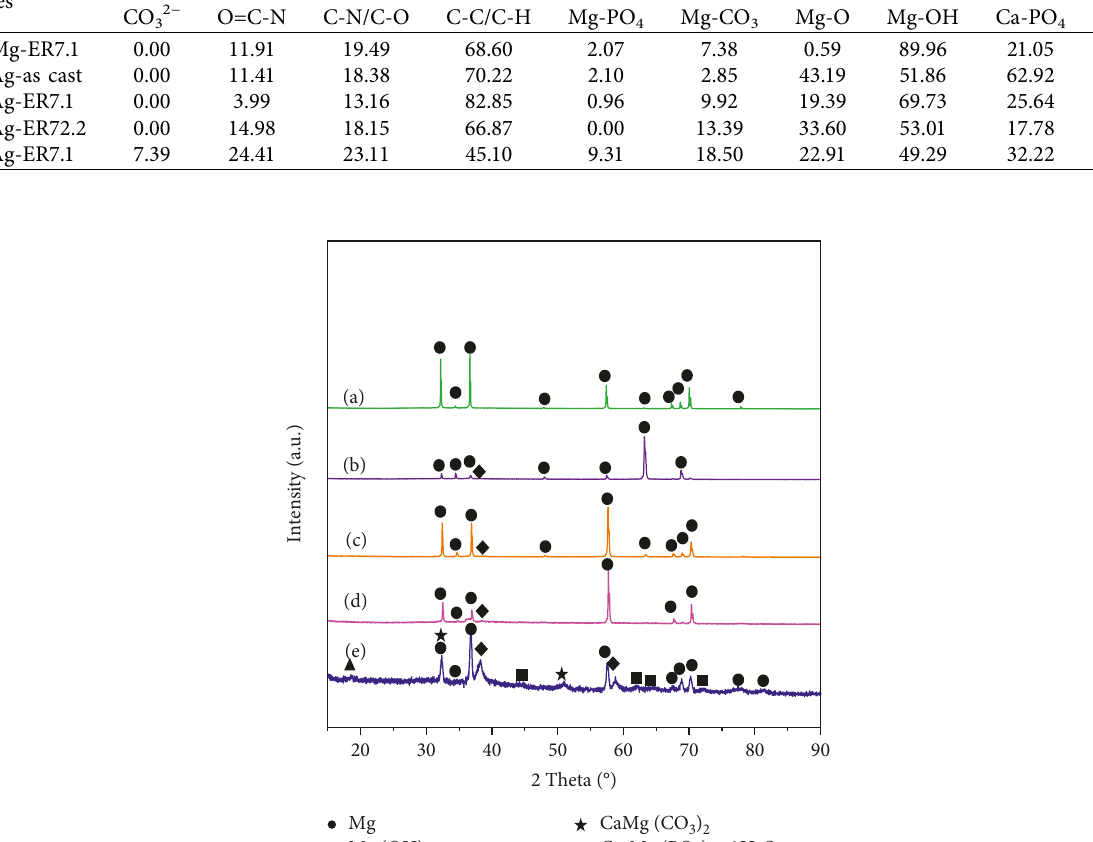
Table 6: Composition of the sample surfaces by high resolution spectra XPS after an immersion test for 16 days. Samples